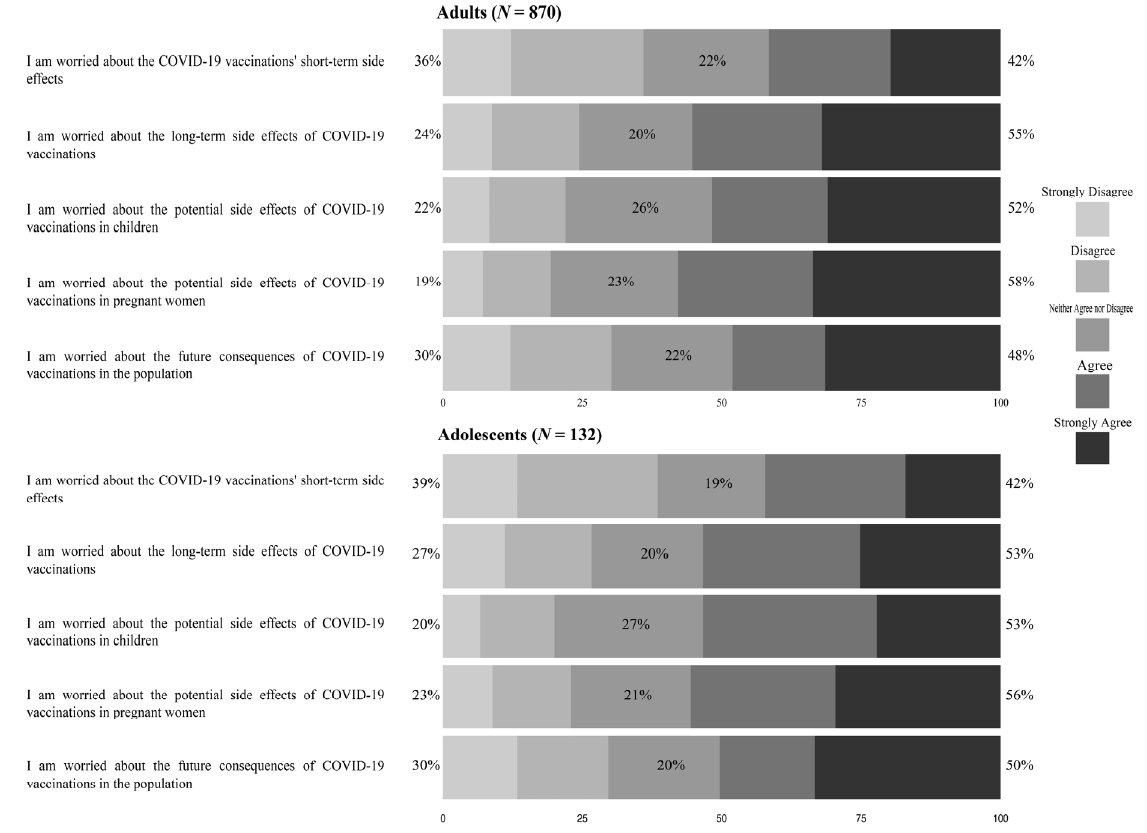
Figure 1. Worry scale regarding COVID-19